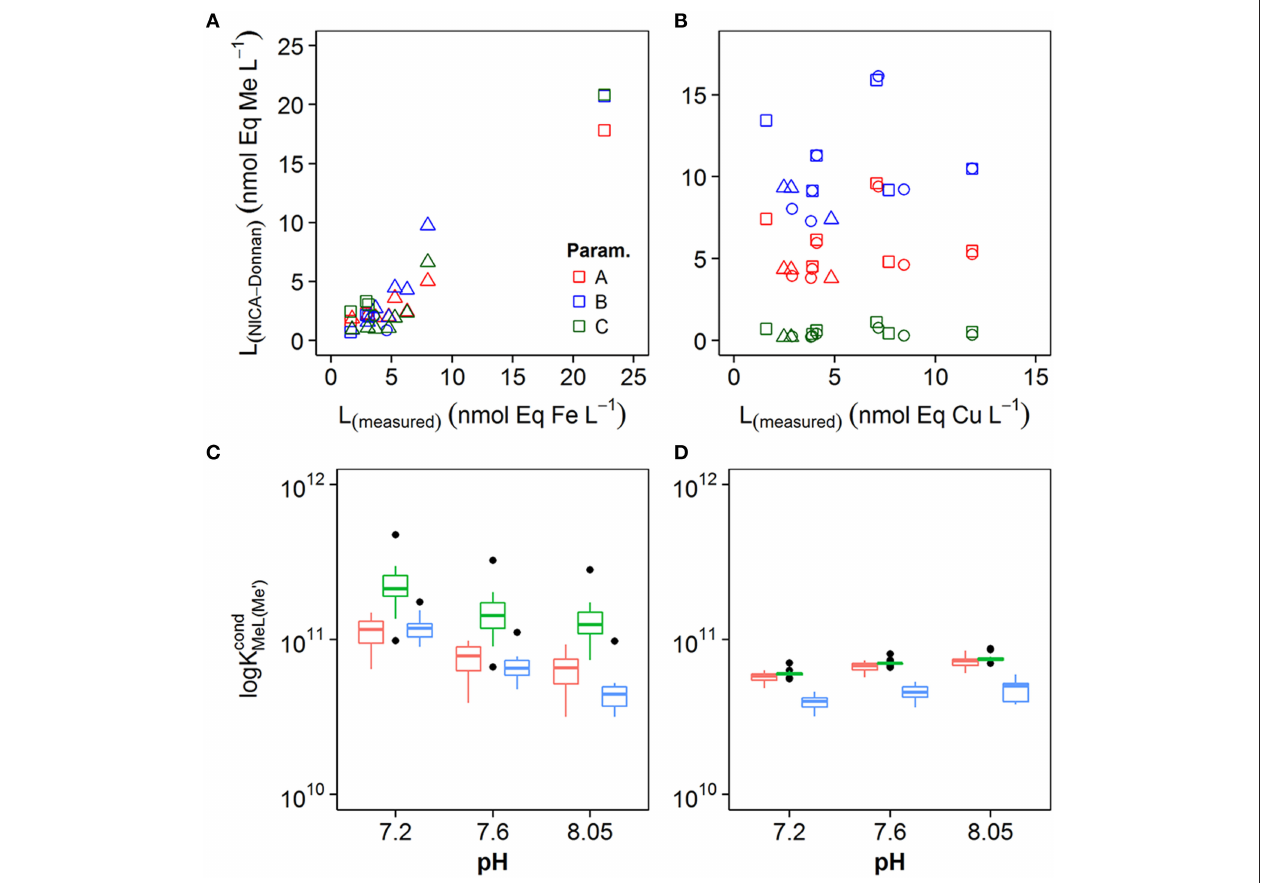
FIGURE 7 | Comparison of ligand concentrations estimated from measured M e A L x ( L (m easured ) ) with ligand concentrations estimated from calculated M e A L x ( L (N ICA − D onnan ) ) for (A) iron and (B) copper. (C) Box and whisker plots obtained for conditional stability constants K cond concentrations at pH 8.0, 7.6, and 7.2 for iron (C) and copper (D) . The box incorporates the 25th and 75th percentiles, whilst outliers are plotted as black diamonds. The parameter sets used to obtain MeAL x are represented by the different colors (see